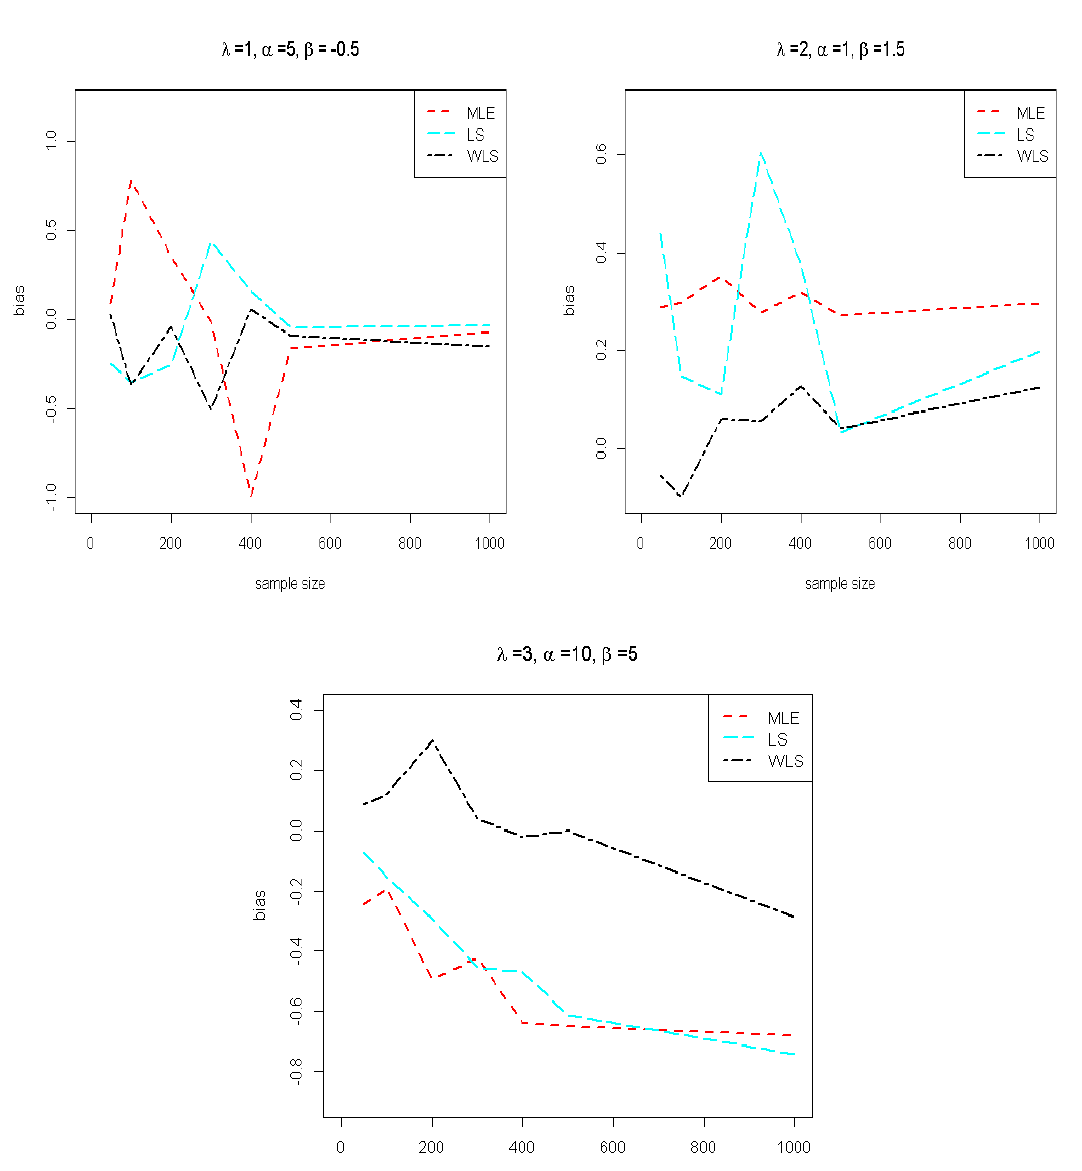
Figure 4. Bias of estimator ˆ α versus sample size n for different